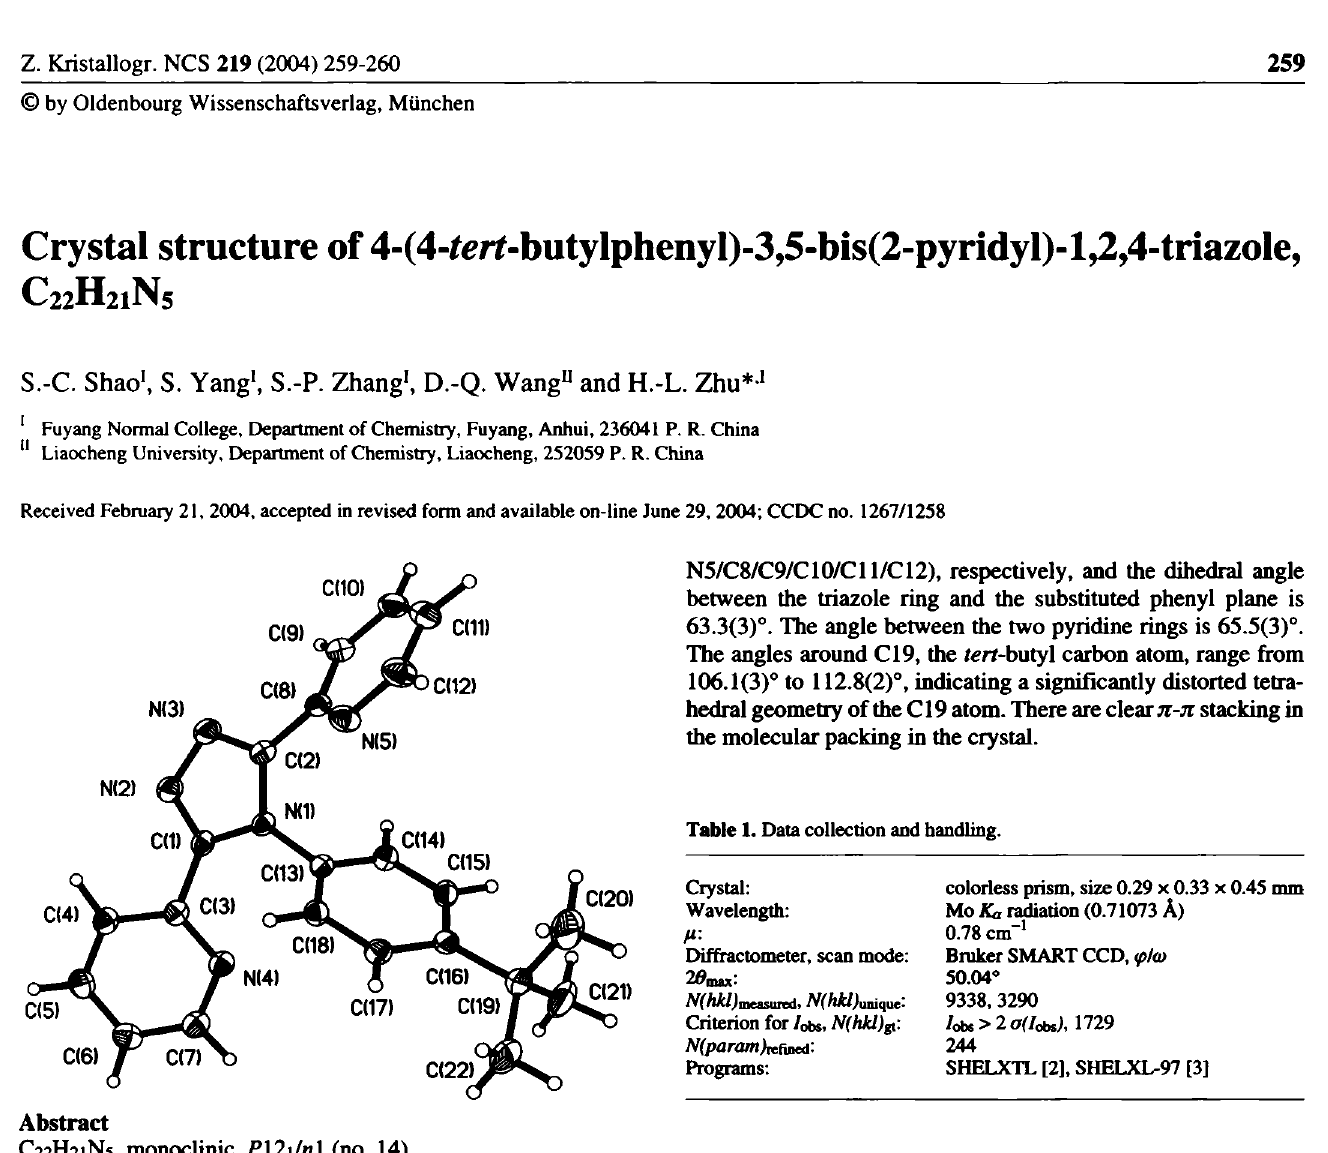
Table 2. Atomic coordinates and displacement parameters (in Â 2